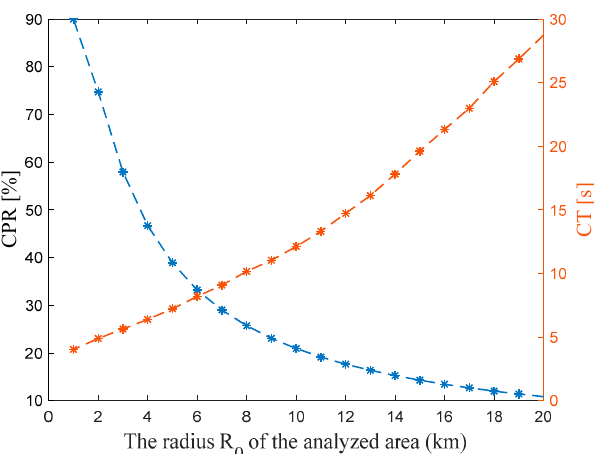
Figure 7. Calculated points ratio CPR and computation time CT for different radius R 0 .